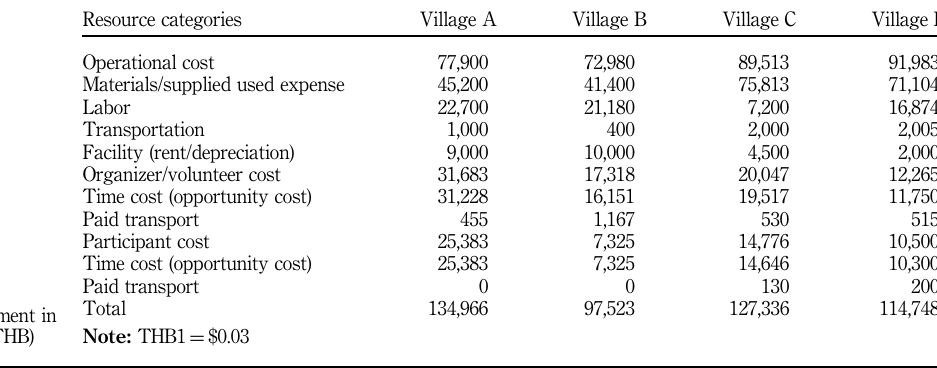
Table II. Cost of investment in each village